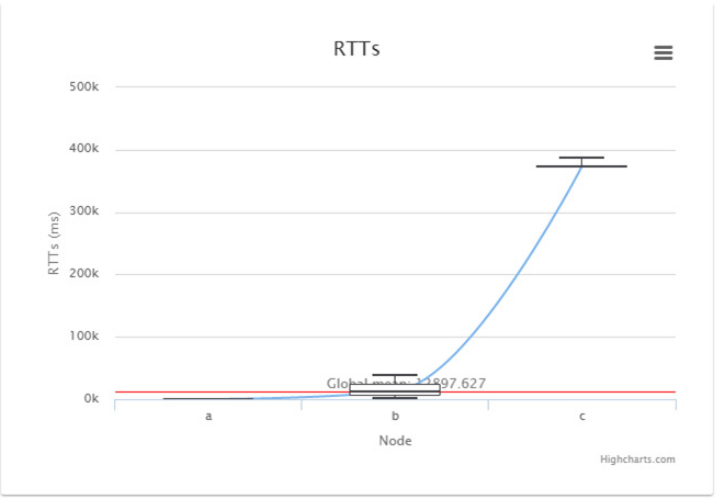
Figure 11. Results display